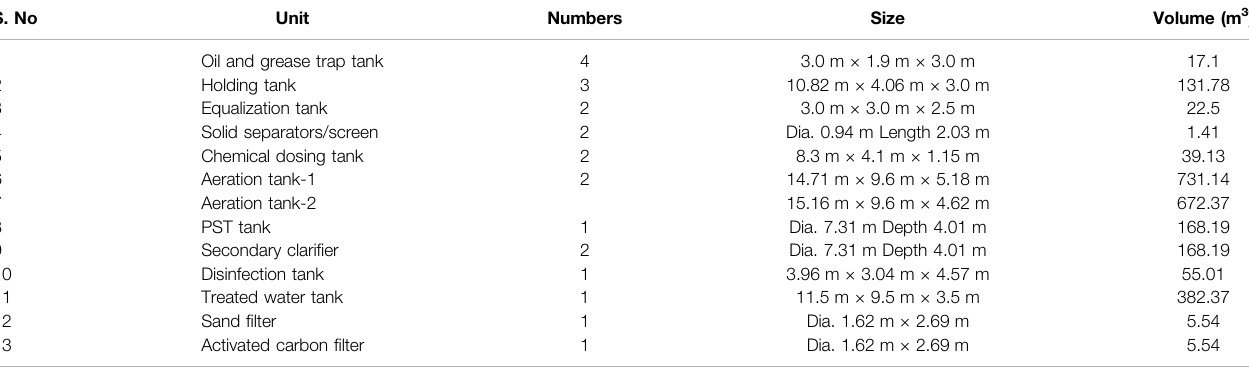
TABLE 3 | Unit sizes of IAF 750 m 3 /d